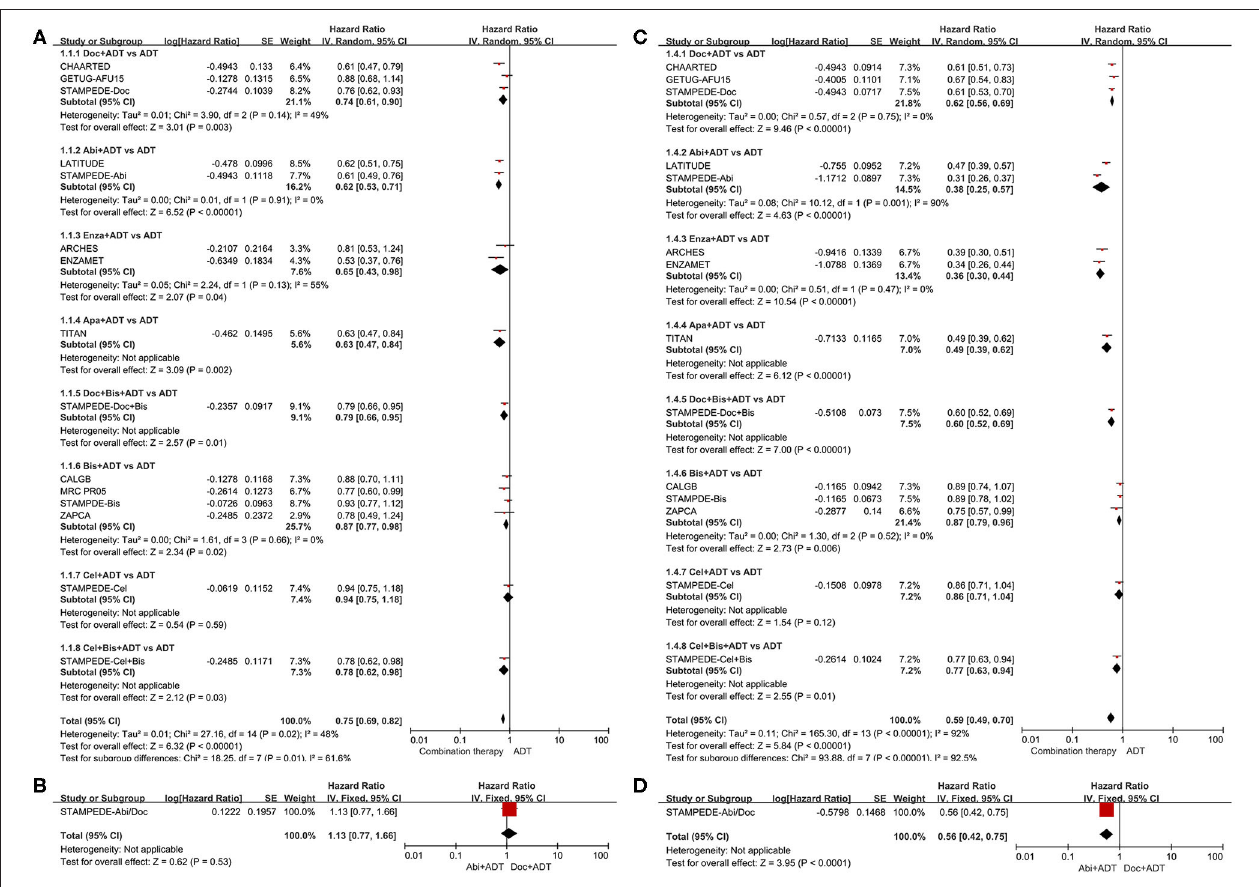
FIGURE 2 | Forest plots of direct comparisons. (A) Effect of combination therapies compared to ADT alone on overall survival. (B) Effect of ADT plus abiraterone compared to ADT plus docetaxel on overall survival. (C) Effect of combination therapies compared to ADT alone on failure-free survival. (D) Effect of ADT plus abiraterone compared to ADT plus docetaxel on failure-free survival. Doc, docetaxel; Abi, abiraterone; Enza, enzalutamide; Apa, apalutamide; Bis, bisphosphonate; Cel, celecoxib; ADT, androgen-deprivation therapy.